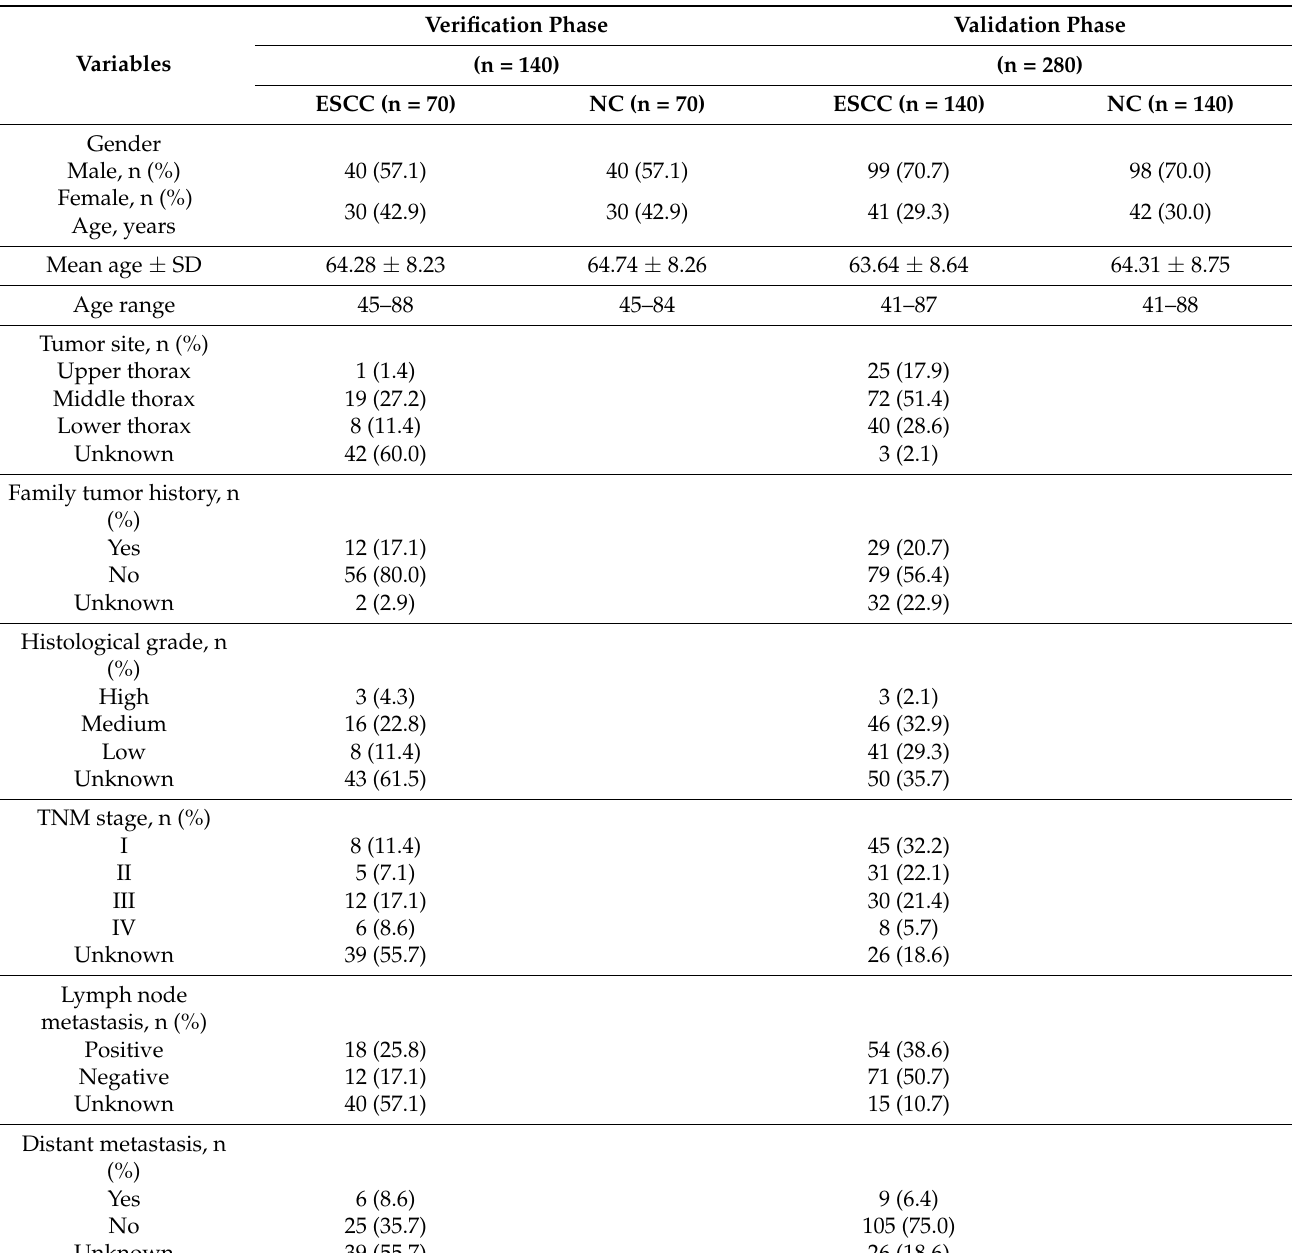
Table 1. Characteristics of study